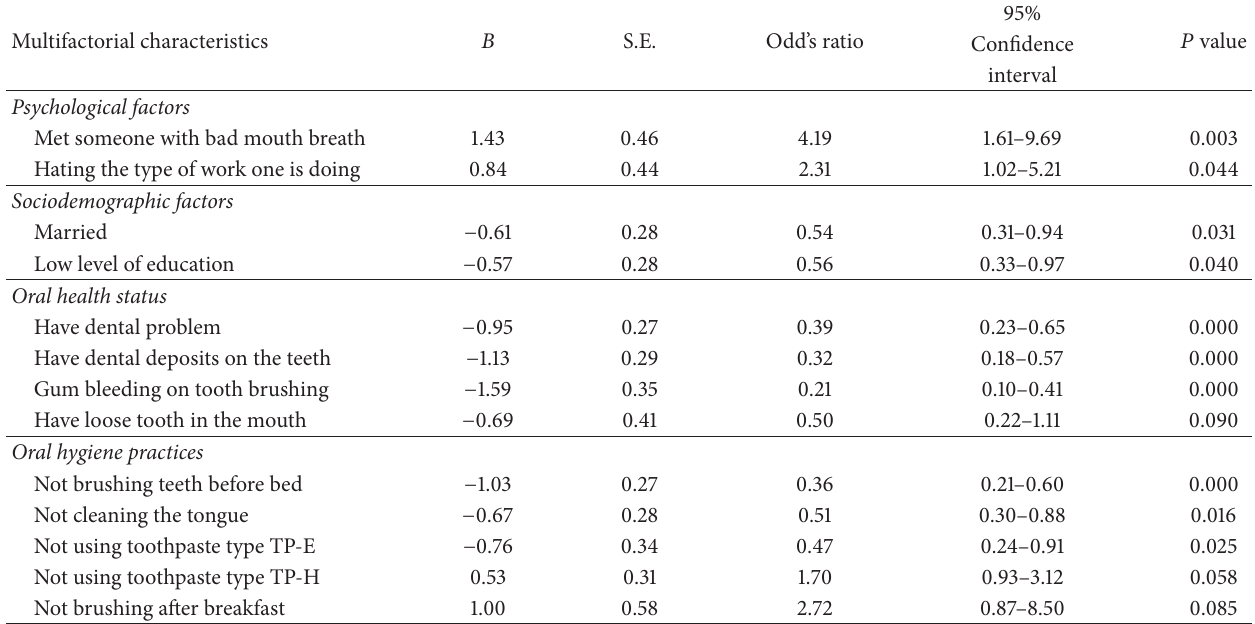
Table 6: Binary logistic regression analyses of the multifactorial characteristics related to self-reported halitosis among the study participants. Multifactorial